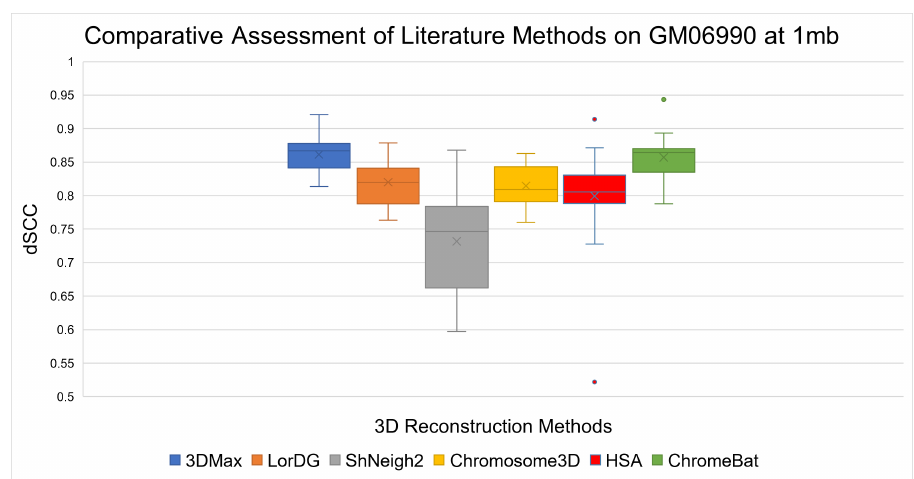
Figure 7. Comparative Assessment of Literature Methods on GM06990. A comparison of the Spear- man Correlation Coefficient between literature methods 3Dmax, LorDG, ShNeigh2, Chromosome3D, HSA, and ChromeBat. This experiment is performed on the first 23 chromosomes of the GM06990 cell line at 1mb resolution using the HindIII restriction enzyme. That is, in each box plot, there is one data point per chromosome that represents the method’s dSCC performance on that chromosome.